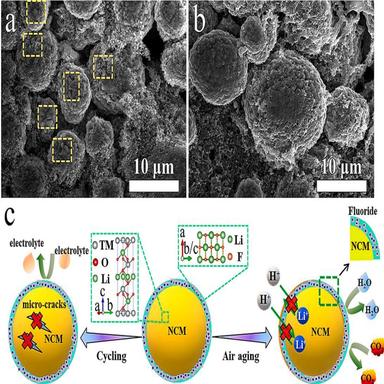
SEM images of (a) P-NCM and (b) NCM-F electrodes after cycling. (c) Schematic illustration of the stabilization mechanism of NCM by fluorides coating.